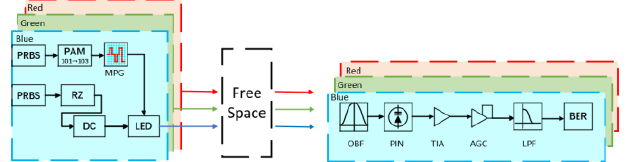
Fig. 1. Multi-Color Visible Light Communication System Using 67% RZ-4PAM